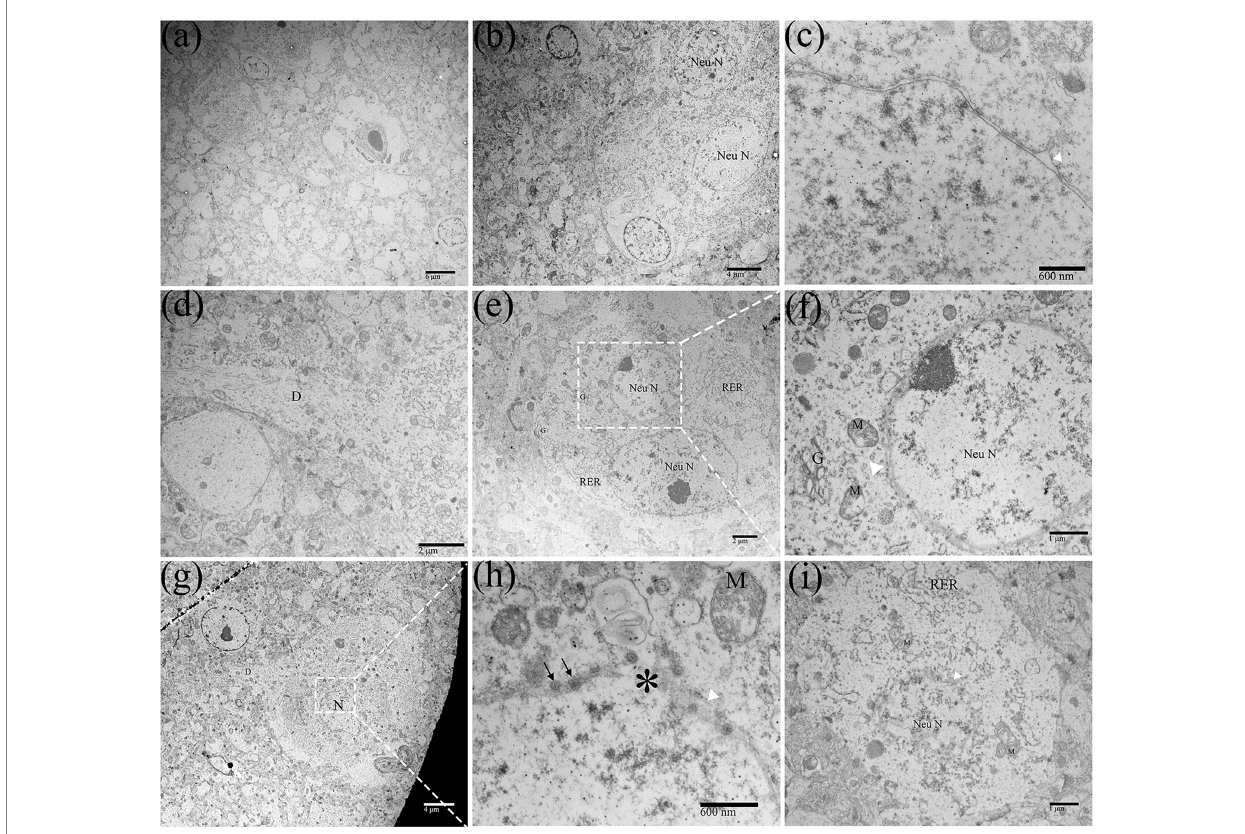
FIGURE 1 Ultrastructural pathological changes of Duck Tembusu virus (DTMUV)-infected neurons in the duckling brain. (A) Brain tissue vacuolization after DTMUV infection. (B) Neurons were the main target cells of DTMUV. (C) The nuclear membrane gap widened. (D) A proximal portion of a dendritic process in an infected neuron. (E,F) The nuclear membrane was thickened (white arrowhead). (G,H) The nuclear membrane was ruptured ( * ), and residual nuclear pore complexes (black arrow) were visible. (I) Nuclear disintegration. RER, rough endoplasmic reticulum; D, dendrite; G, golgi apparatus; Neu N, neuron nucleus; and M,